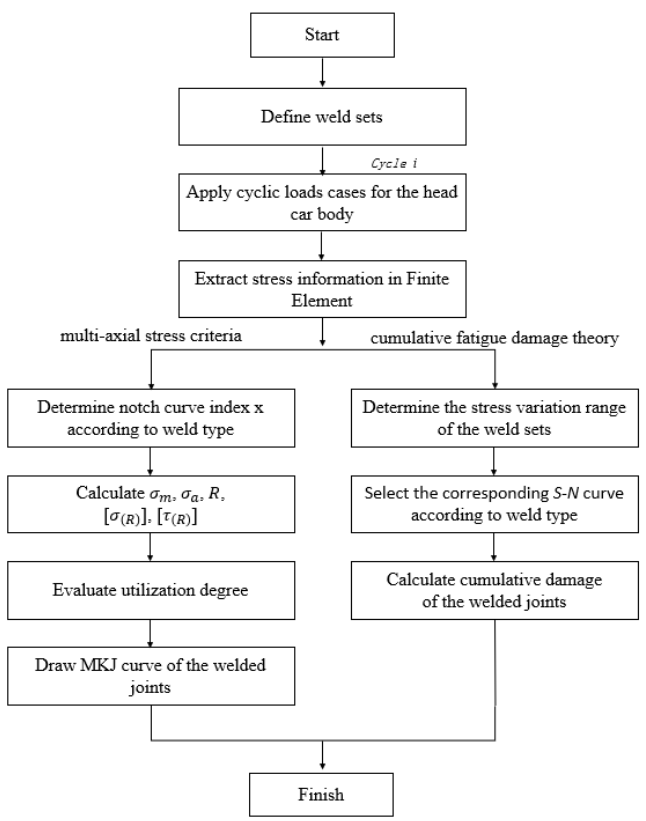
Figure 4. Flow chart of the fatigue life evaluation based on two methods.